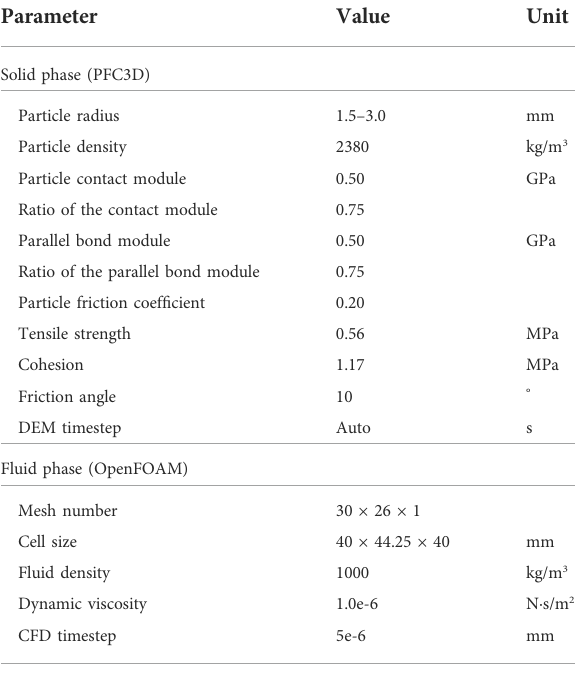
TABLE 5 Detailed parameters adopted in the submerged anti-dip slope